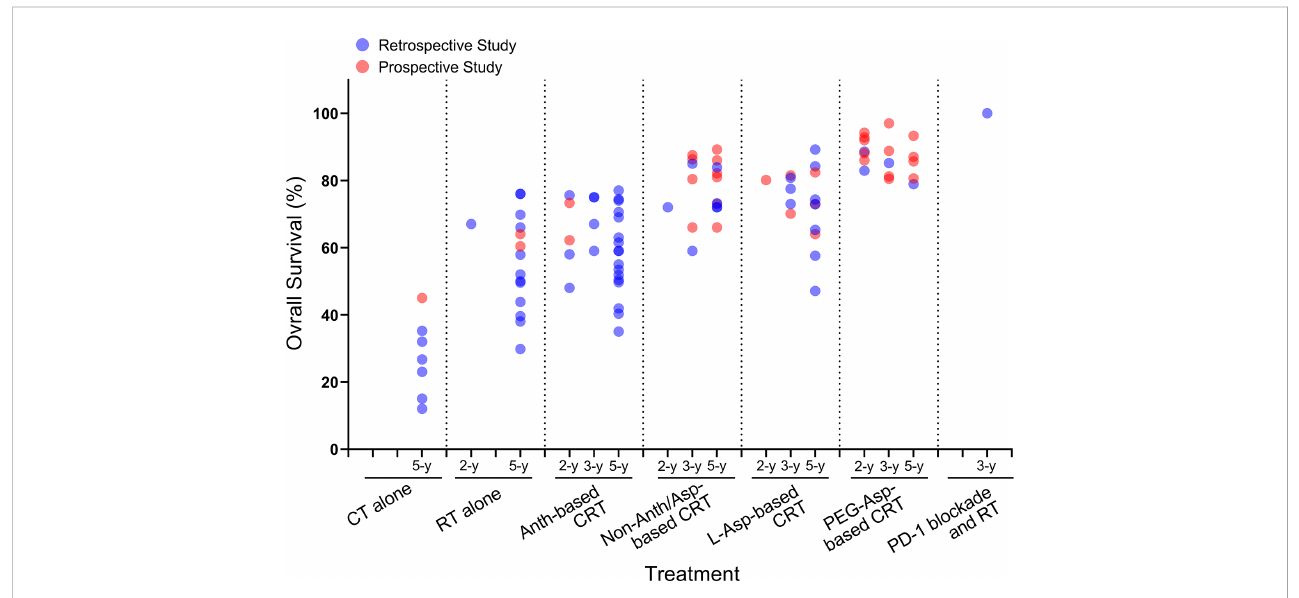
FIGURE 5 OS trends in early-stage ENKTCL patients treated with different modalities. CT, chemotherapy; RT, radiotherapy; Anth, anthracycline; CRT, chemoradiotherapy; Asp, asparaginase; PEG-Asp, pegaspargase; OS, overall survival. Data cited from (4, 27 – 32, 34 – 37, 39, 40, 42 – 46, 48 – 82, 84 –